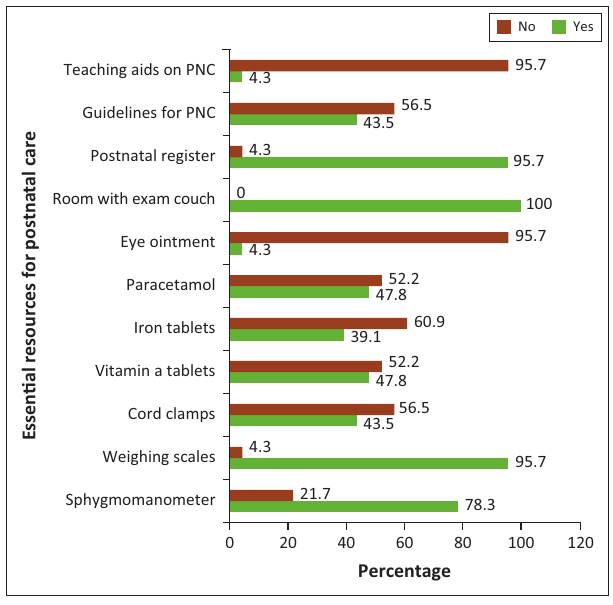
FIGURE 1: Availability of essential resources for postnatal